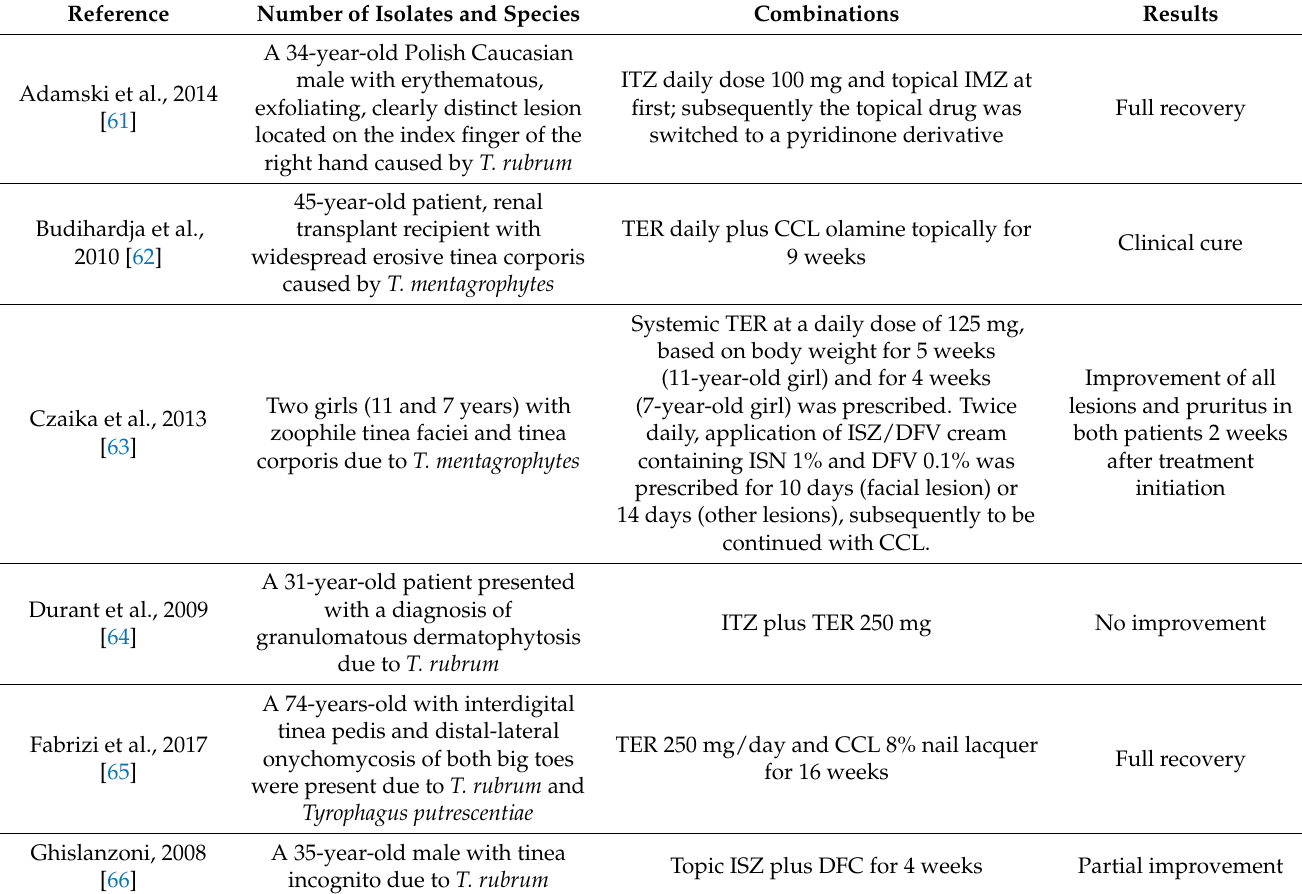
Table 3. Antifungal combinations against dermatophytes: clinical